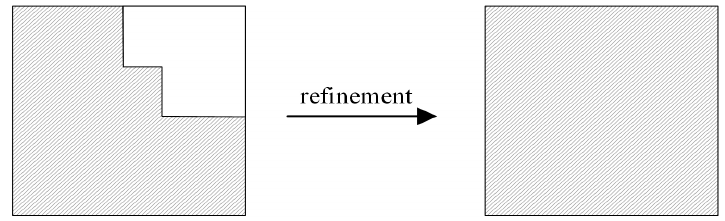
Figure 2. The refinement process of SPF. the shaded part represents pixNum max , the blank part represents other classes.